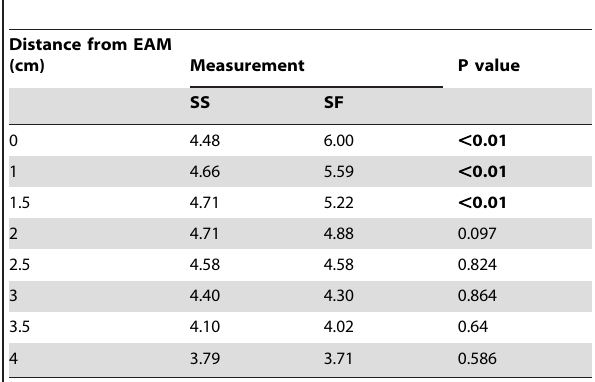
Table 2. P value for Squamous suture and Sylvian fissure in each location measured (Right).